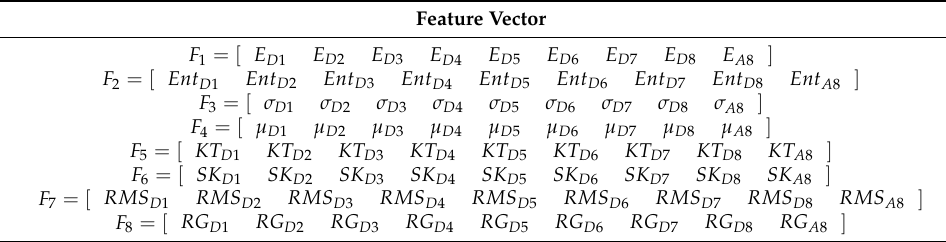
Table 3. Feature vectors created from statistical